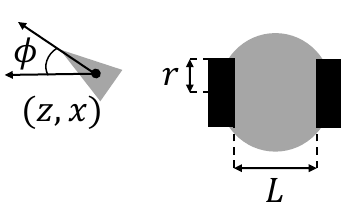
Figure 4. Differential drive mobile robot.